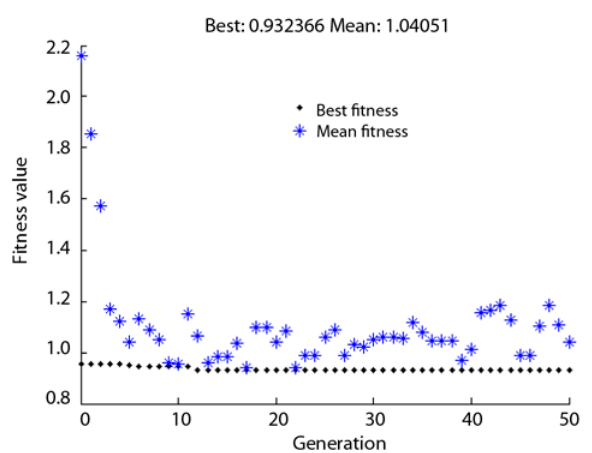
Fig. 5. Fitness values achieved by the proposed